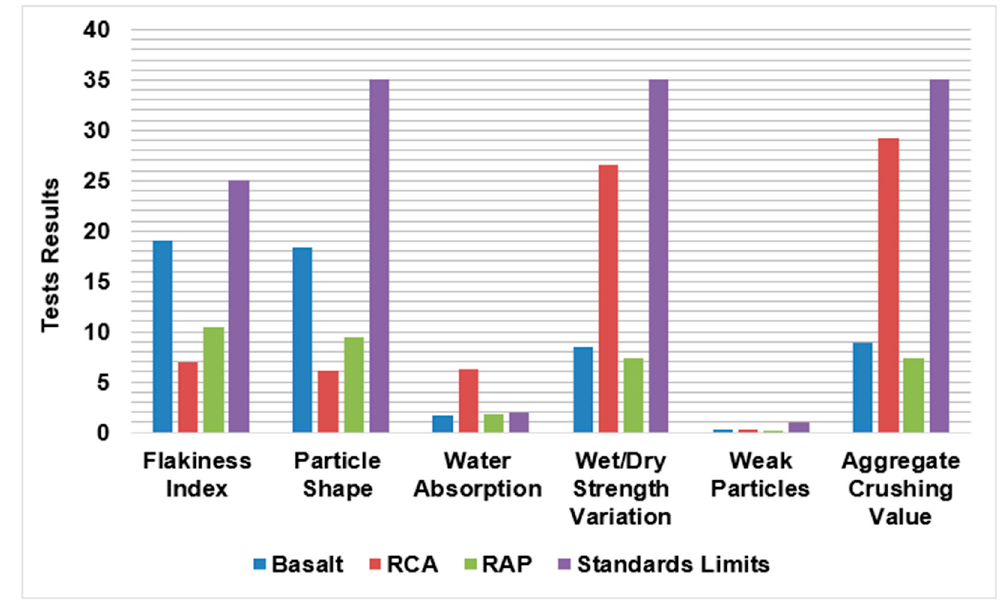
Figure 13. Comparison of Different Aggregate Properties with Standard Limits.